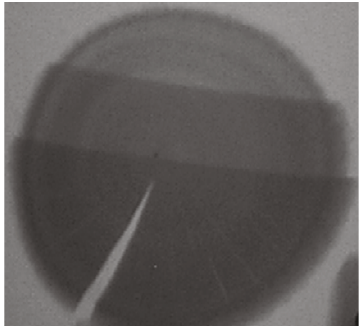
Figure 6: Original wood